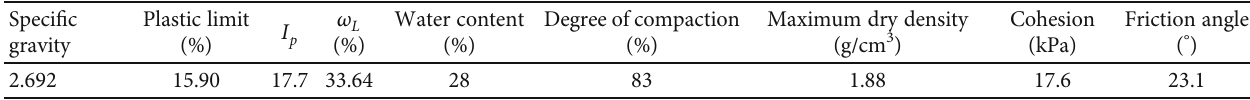
Figure 2: Schematic diagram of the model test. Table 1: The geoparameters of the testing